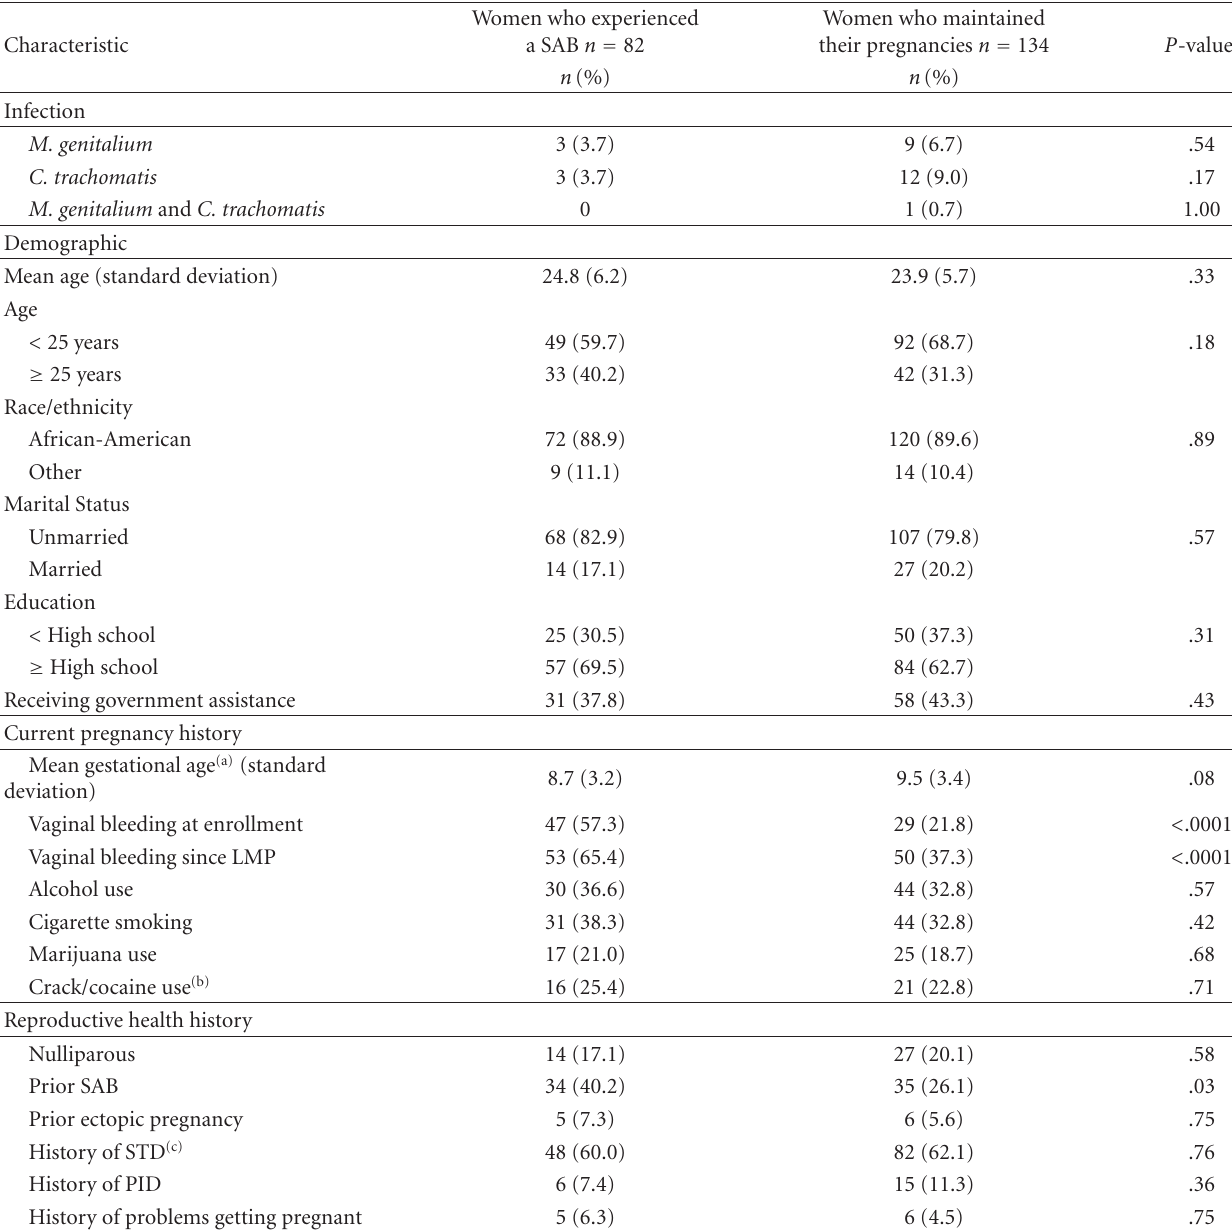
Table 1: Characteristics of women who experienced a SAB and women who maintained their pregnancies past 22 weeks gestation.